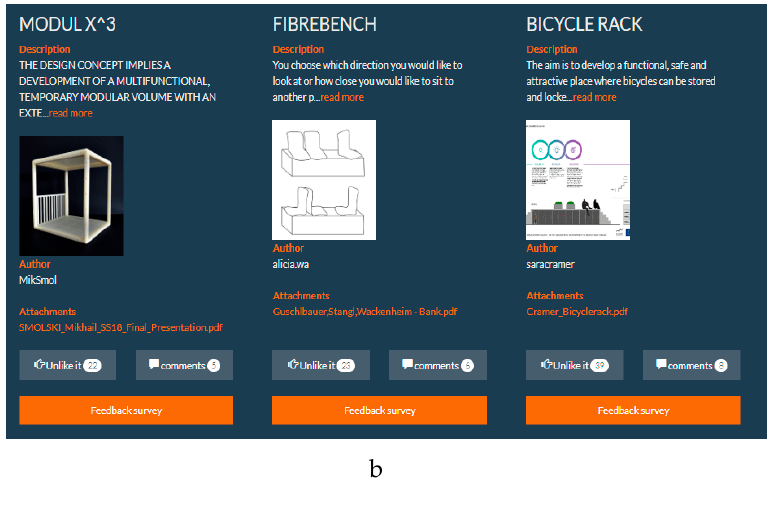
Figure 3. Idea manager tool: search and process ideas ( a ) and collaborating on ideas ( b ) .